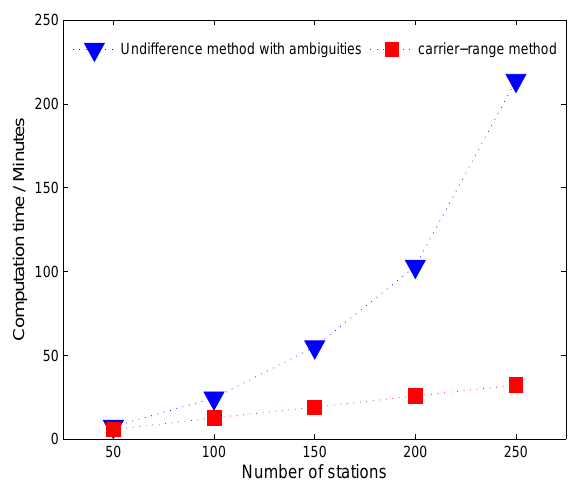
Figure 4. Comparison of computation times of the new method (red squares) and traditional method (blue triangles) for networks with different number of stations.